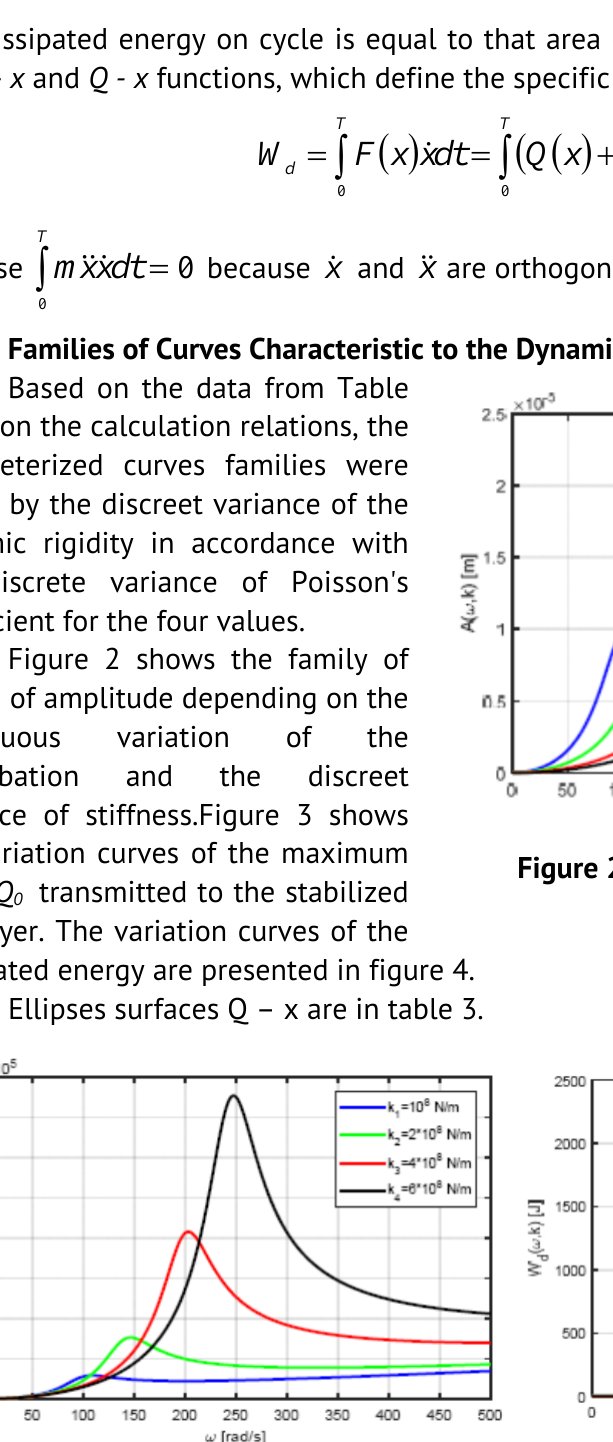
Figure 3. Variation of the maximum force transmitted in relation to (cid:2033) and (cid:1863) .